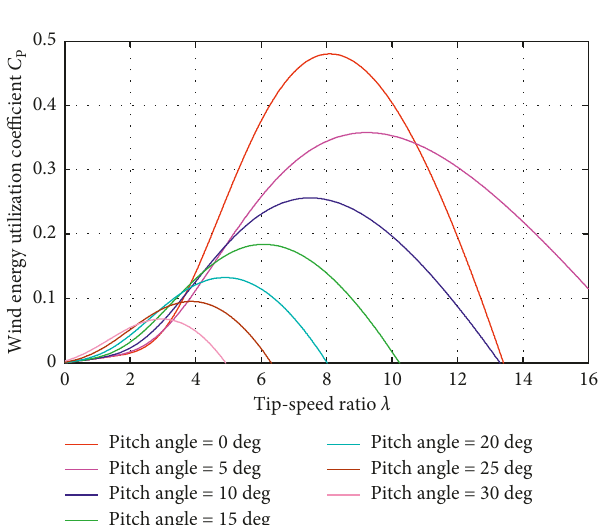
Figure 5: Inner control of current (remark: PI parameters are denoted as k i P and k i I ). (a) Current feedforward decoupling control. (b) First-order tuning for PI